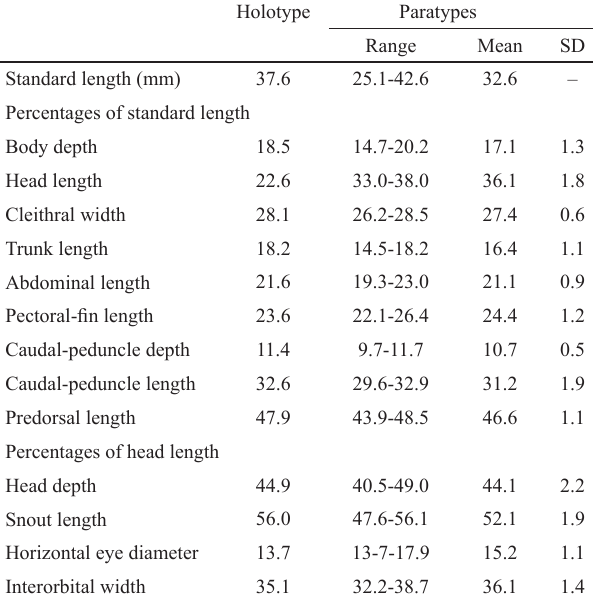
Table 1. Morphometric data of holotype (MZUSP 113422) and 24 paratypes of Parotocinclus seridoensis . Abbreviations: SD, standard